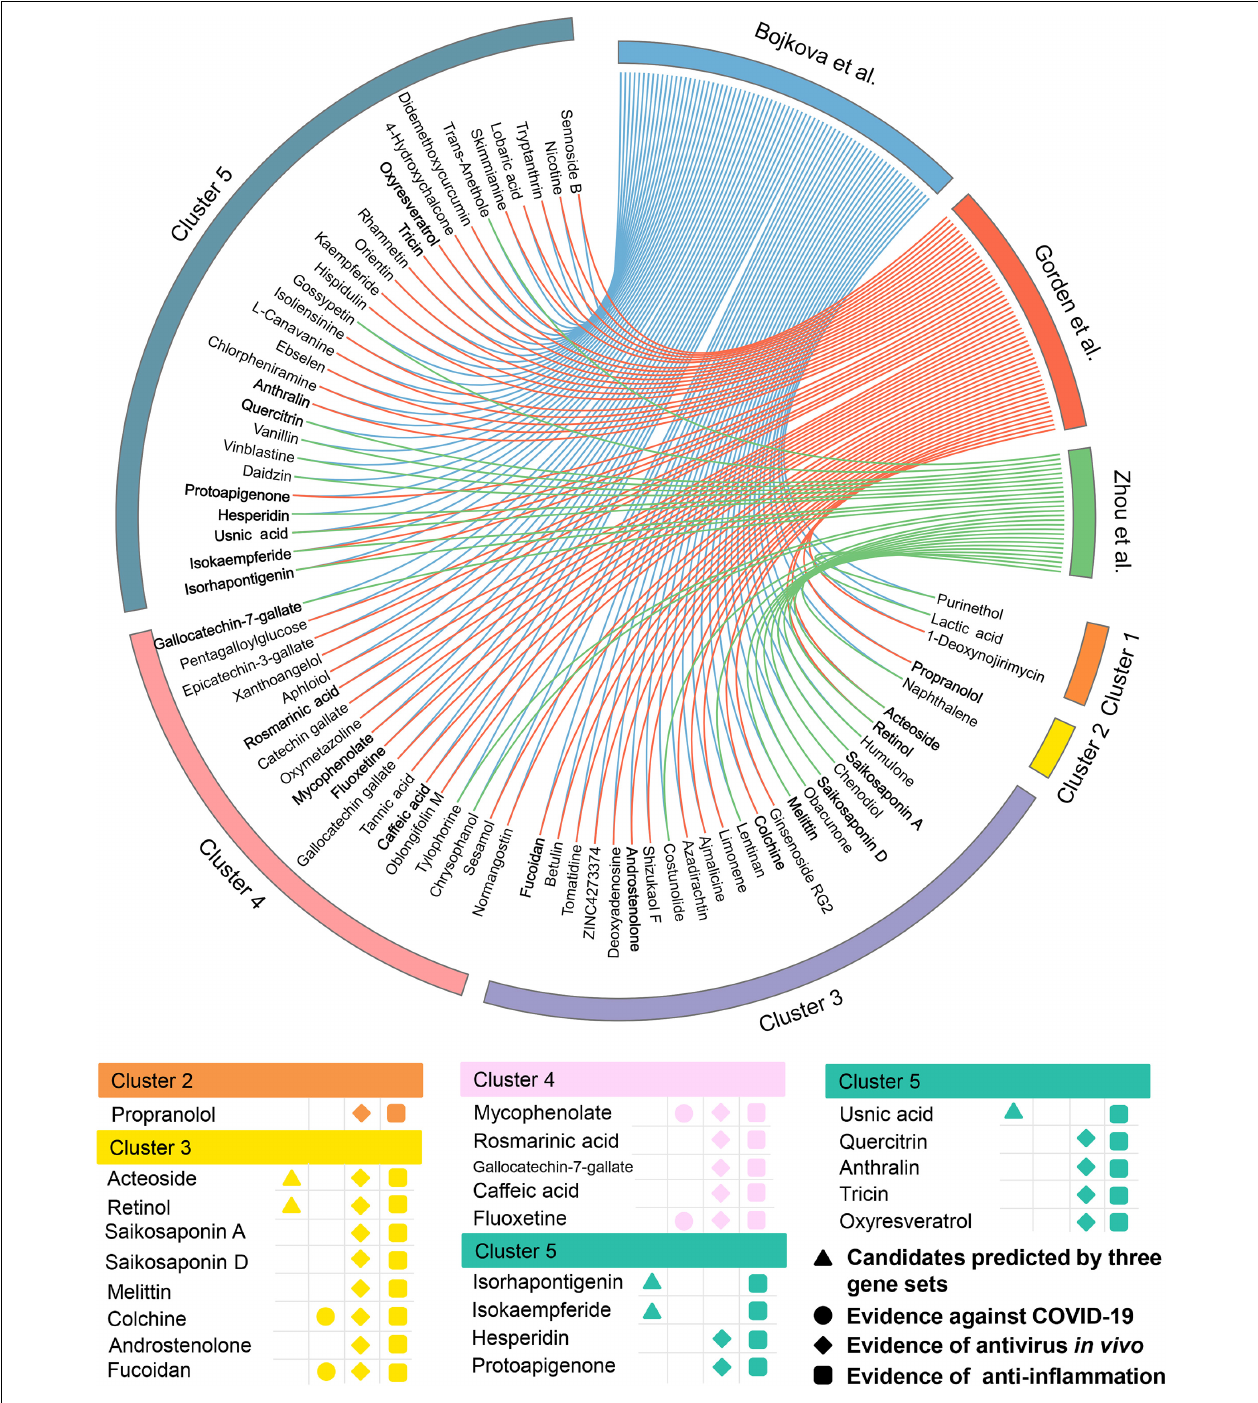
FIGURE 6 | Network-based in silico prediction of natural products against COVID-19. Circos plot exhibiting 74 predicted natural products identified by network proximity analysis. The full version exhibiting all the predicted natural products ( p < 0.05) is provided in Supplementary Table 4 . All natural products are clustered by their scaffold structures. Twenty-three best natural product candidates were selected based on multiple studies from antivirus in vivo and anti-inflammation.